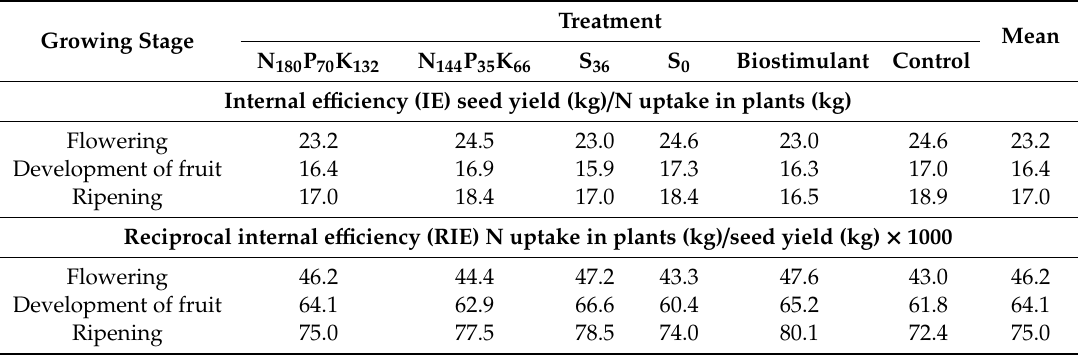
Table 4. Internal e ffi ciency and reciprocal internal e ffi ciency of nitrogen mean from 2011 to 2013. Growing Stage